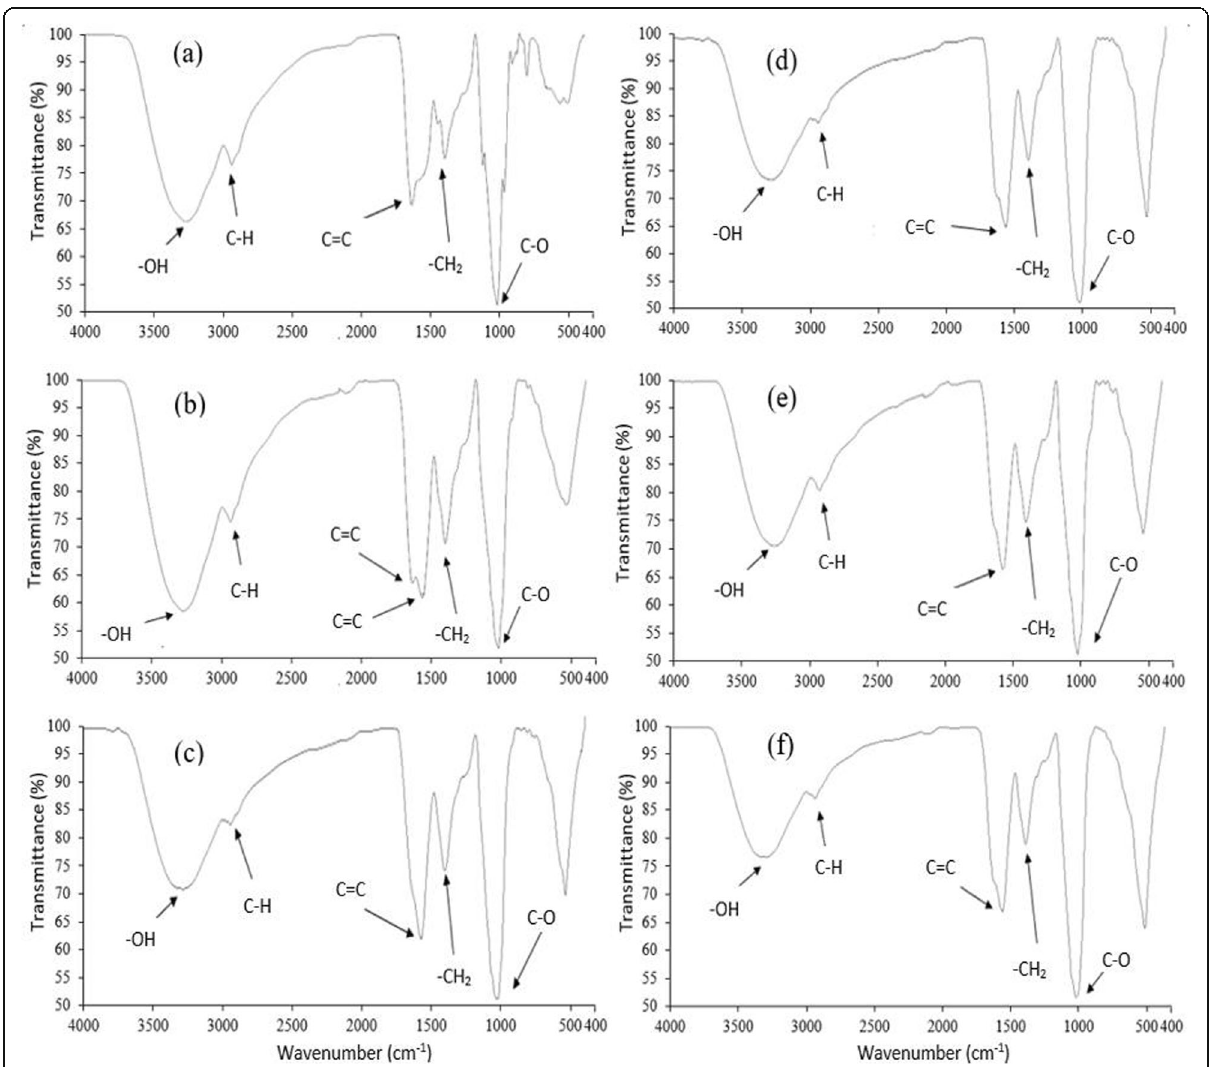
Fig. 4 FTIR spectrum for EPS derived from B. cereus cultivated under sugarcane molasses at different concentrations ( a ) control ( b ) 1% ( c ) 2% ( d ) 3% ( e ) 4% ( f ) 5%, indicating functional groups detected. The peaks indicate O-H stretching (3650 – 3200 cm − 1 ), C-H stretching (3000 – 2850 cm − 1 ), C=C stretching (1680 – 1450 cm − 1 ), − CH 2 bending (1500 – 1320 cm − 1 ) and C-O stretching (1300 – 1000 cm − 1